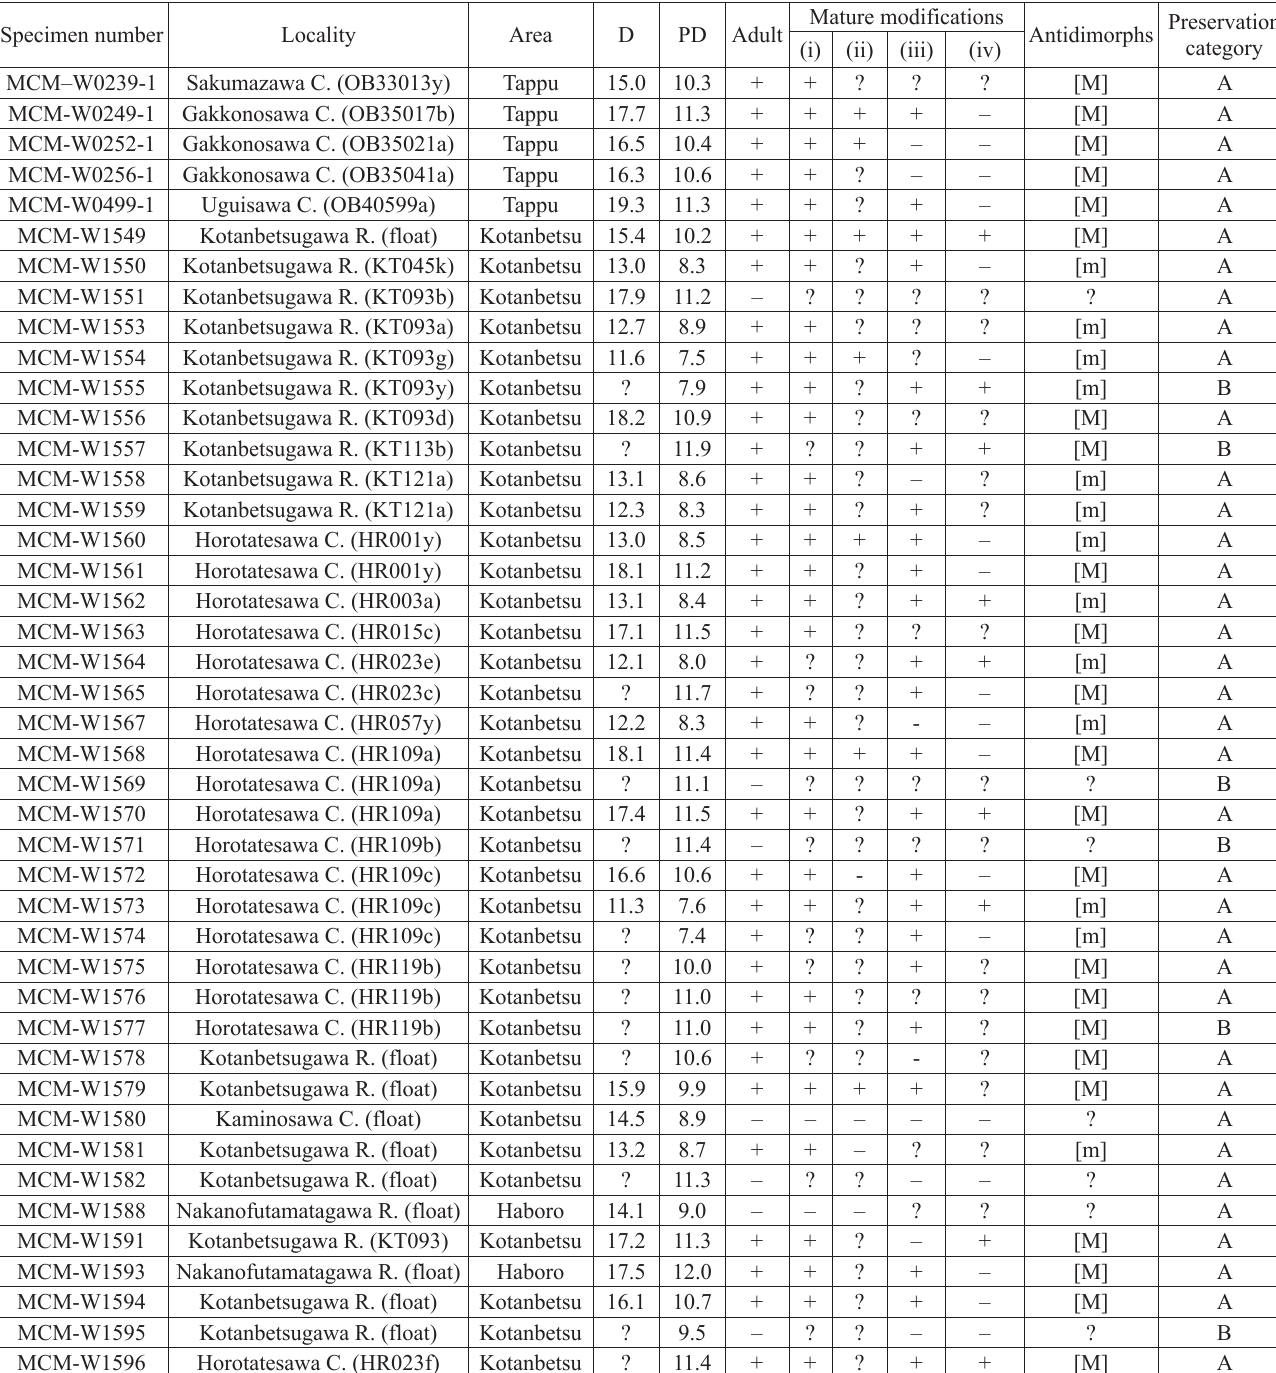
Table 1. List of Santonian specimens of tetragonitid ammonoid Tetragonites minimus Shigeta, 1989, from the Yezo Group in Hokkaido, Japan. Measurements in mm. Abbrevitions: C., Creek; D, shell diameter; [m], microconch; [M], macroconch; PD, phragmocone diameter; R., River; + satisfied; – unsatisfied; ?, unmeasurable or undecidable. The preservation categories: A, complete or almost intact; B,